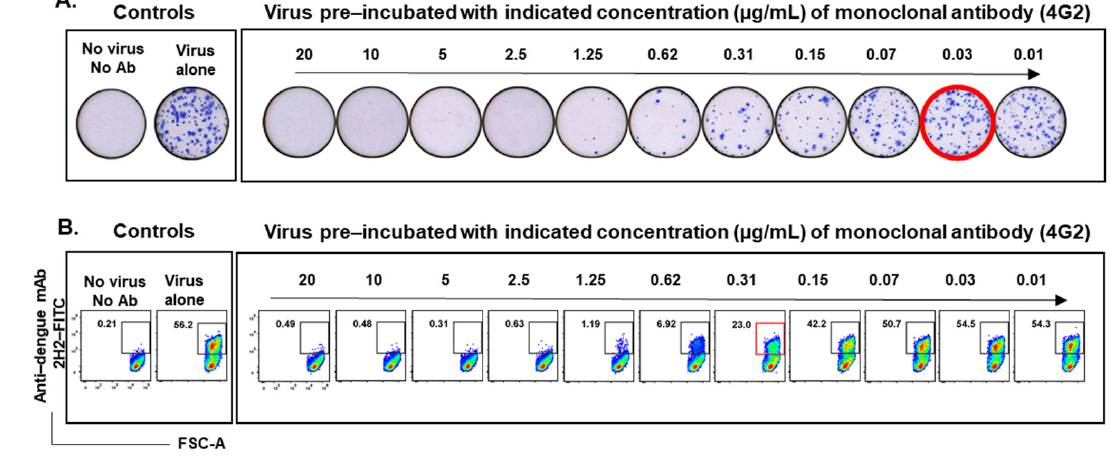
Figure 1. Comparison of neutralization titers obtained by FRNT and flow cytometry based assays using 4G2 monoclonal antibody. ( A ) Raw data on DENV2 neutralization by 4G2 monoclonal anti- body in Vero cells using the focus reduction neutralization test (FRNT). Red circles indicate the 50% neutralizing titer (FRNT 50 ). ( B ) Raw data on DENV2 neutralization by 4G2 monoclonal antibody in Vero cells using the flow-based neutralization assay. Red box indicates the approximate dilution at which 50% neutralization occurred. ( C ) The horizontal dotted line plotted over the nonlinear dose– response regression analysis indicates the concentration of 4G2 monoclonal antibody needed to cause 50% reduction of neutralization using the FRNT (blue line) and the flow cytometry-based assay (red line) in three independent experiments using different batches of the 4G2 MAb. We next asked whether the flow cytometry based assay, using the assay conditions described above, would also underestimate neutralization titers in human plasma sam- ples. For this, we initially chose two previously well-characterized plasma samples, one of which had a very high neutralization titer of around 10 4 and another having a very low neutralization titer of around 10 2 for dengue virus 2 [13]. Figure 2A shows the comparison of percent neutralization at graded dilutions of the plasma using the two types of assay. Consistent with our findings using the monoclonal antibody, we again found that the flow cytometry based assay vastly underestimated neutralization titers as compared to the FRNT-based titer when we used a highly neutralizing plasma sample (Figure 2A(left)), and even failed to score any neutralization activity when we used plasma with low levels of neutralizing antibodies (Figure 2A(right)). Comparison of additional plasma samples with intermediate neutralization titers further confirmed a poor correlation between these two assays (Figure 2B). These results prompted us to make efforts to further optimize the flow-based assay to improve its sensitivity and ensure that the titers obtained by this method are in better concordance with the titers obtained by the FRNT-based assay.